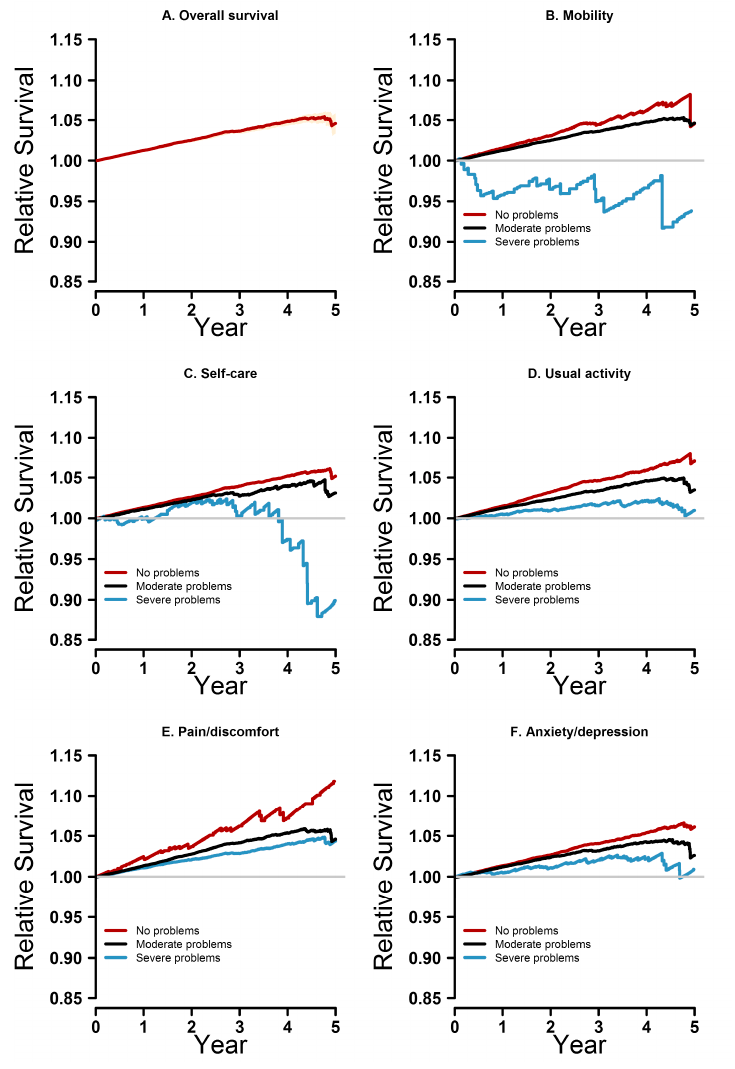
Figure 2. Relative survival curves for the overall study population ( A ) and broken down by the five dimensions of the EQ-5D-3L ( B – F ). All our survival analyses are based on recorded PROMs preoperatively.